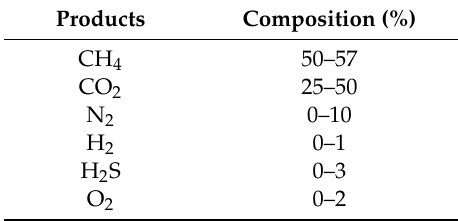
Table 2. The range of percentage composition of the products of biogas. Adapted from [53].